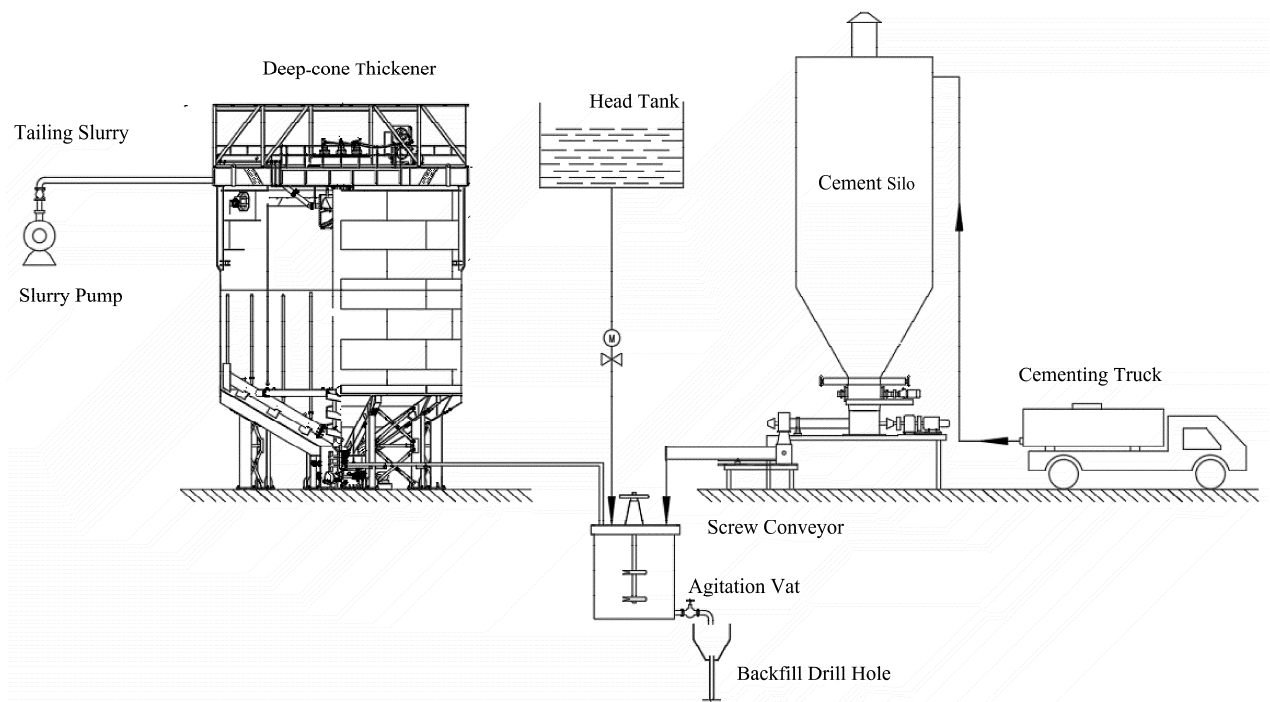
Figure 4. (Source elaborated by authors) Process flow of deep-cone thickener backfill system process.